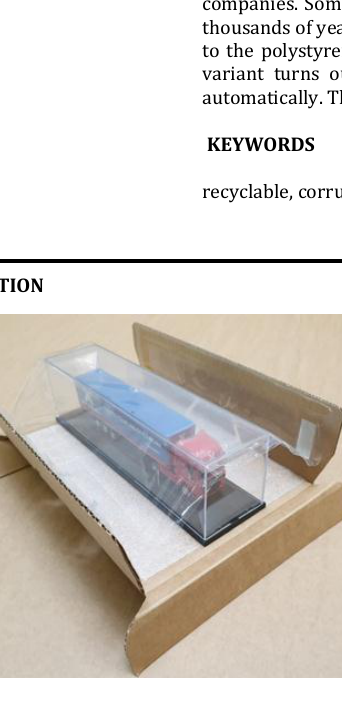
Figure 1: Korrvu® suspension packaging